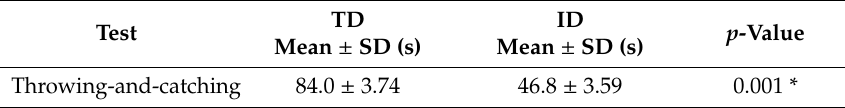
Figure 11. Results of R throwing − and − catching . The paticipants with ID exhibited clearly lower throwing- and-catching rates than the typically developing (TD) participants. Table 7. ANOVA results of the throwing-and-catching rate for the two